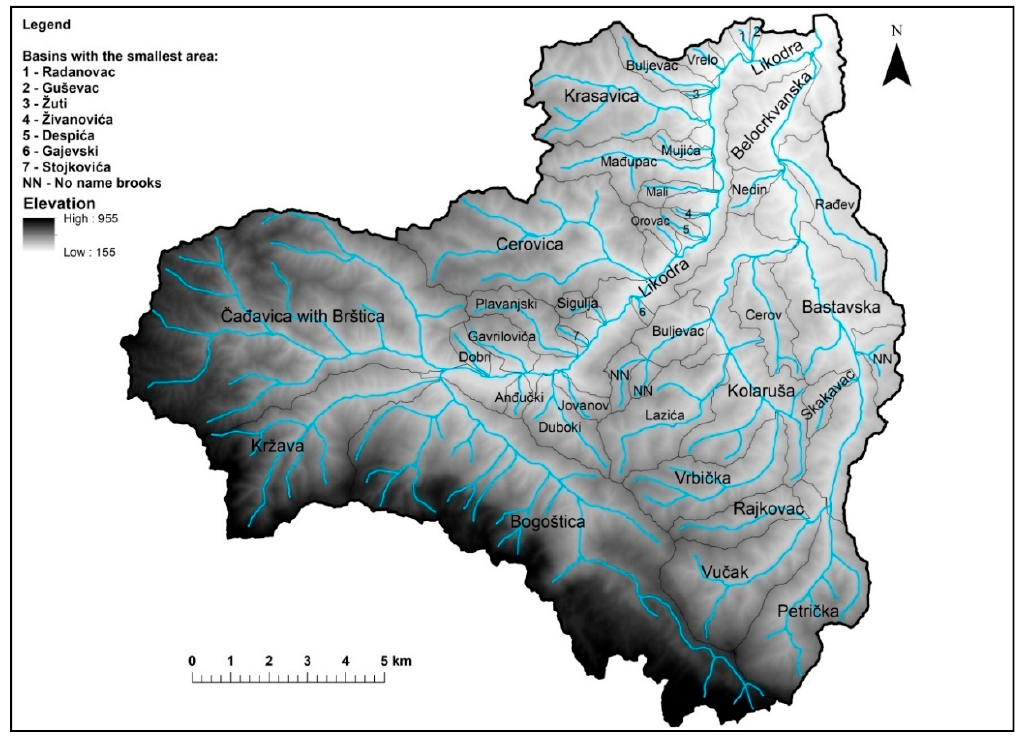
Figure 2. Relief of the Likodra river basin.